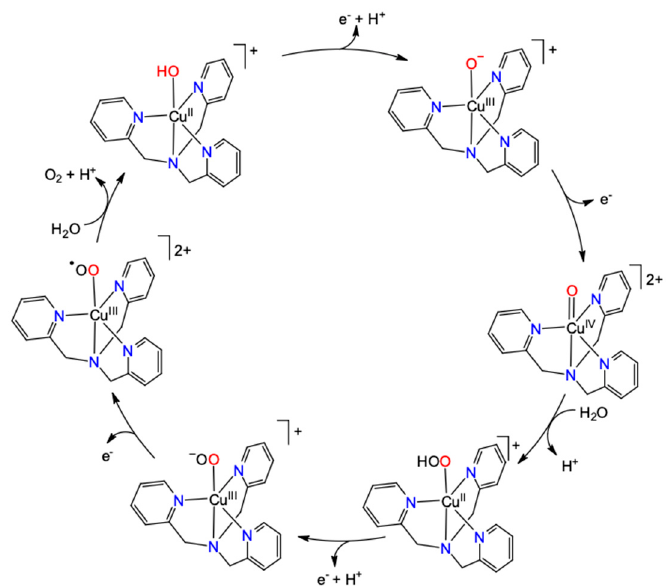
Figure Figure 16. Proposed mechanism for the tris(2-pyridylmethyl)amine (TPA)-based molecular catalyst [65].